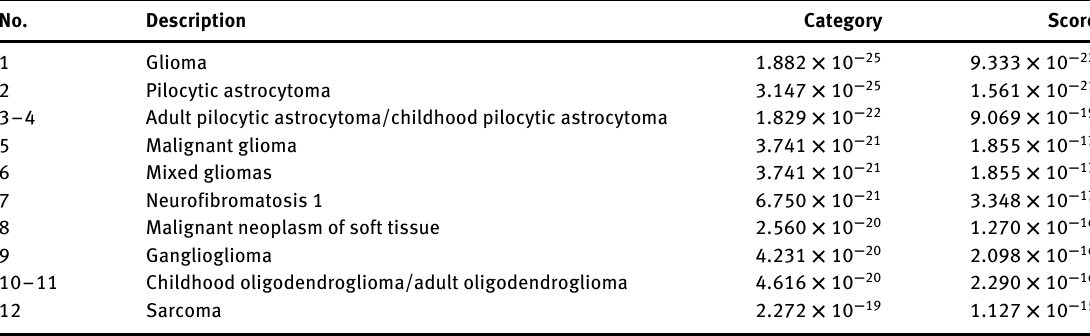
Table 5: Diseases found by prioritization of shared genes to